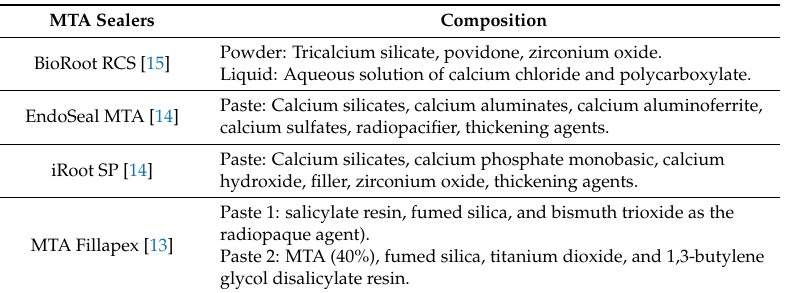
Table 2. Composition comparisons of MTA sealer